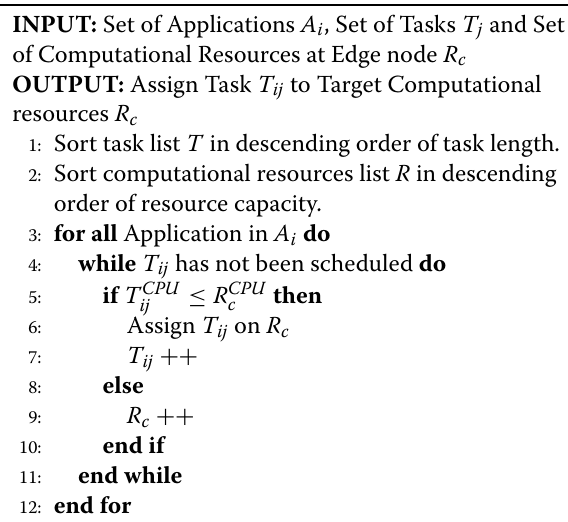
Algorithm 2: Task Scheduling